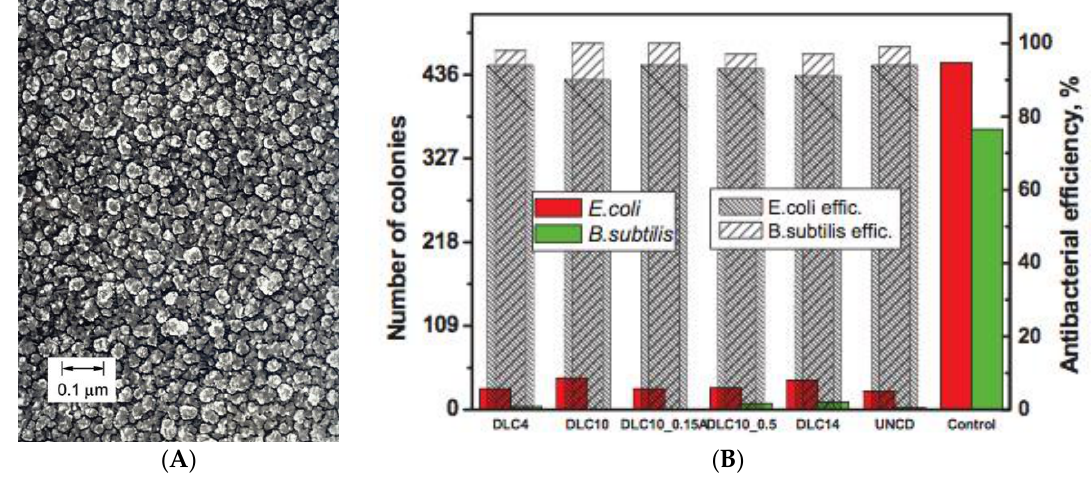
Figure 5. ( A ) DLC film; and ( B ) number of E. coli and B. subtilis colonies on DLC and UNCD films and the respective antibacterial efficiency. Obtained from [87], with permission of John Wiley & Sons 2013.